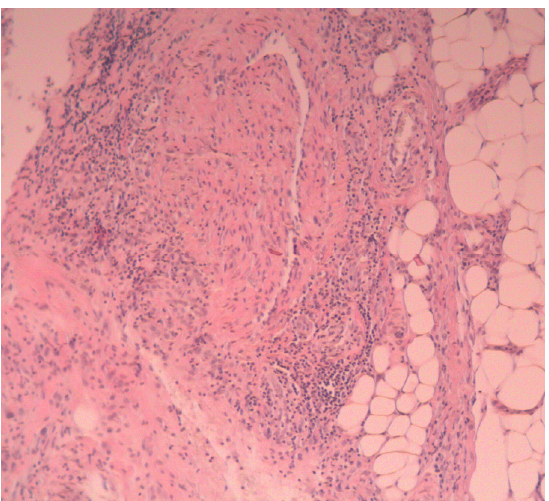
Figure 3. Histopathological examination: acute inflammatory infiltration in the subcutaneous tissue, mainly neutrophilic, with necrotic foci, penetrating into the subcutaneous connective tissue. After the exclusion of bacterial background (sterile blood cultures, Quantiferon Gold, pulses of methylprednisolone (500 mg every day for 3 days), followed by prednisone 40 mg, were included in the treatment. Fever resolved, and the patient’s